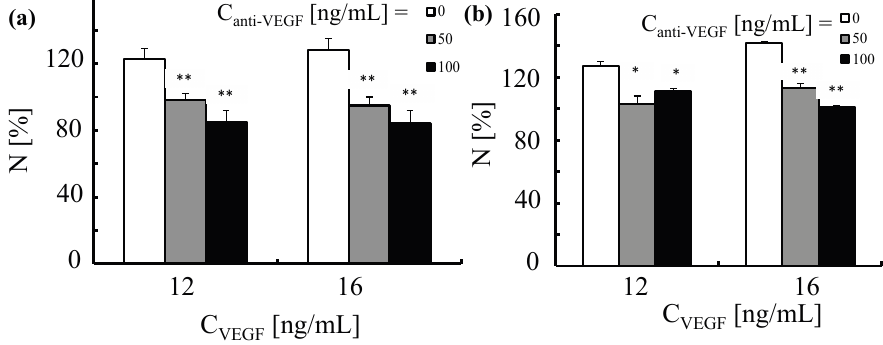
Figure 15. Proliferation of human umbilical vein endothelial cells triggered by VEGF and neutralization induced by anti-VEGF antibody. HUVECs were first exposed for 2 h to anti-VEGF antibody at two concentrations ( C anti-VEGF = 50 and 100 ng/mL). This was followed by the incubation with VEGF ( C VEGF = 12 and 16 ng/mL) for ( a ) 24 and ( b ) 48 h. The number of cells was normalized to 100% for untreated control cells. * p < 0.01; ** p < 0.001( versus cells treated with VEGF only).